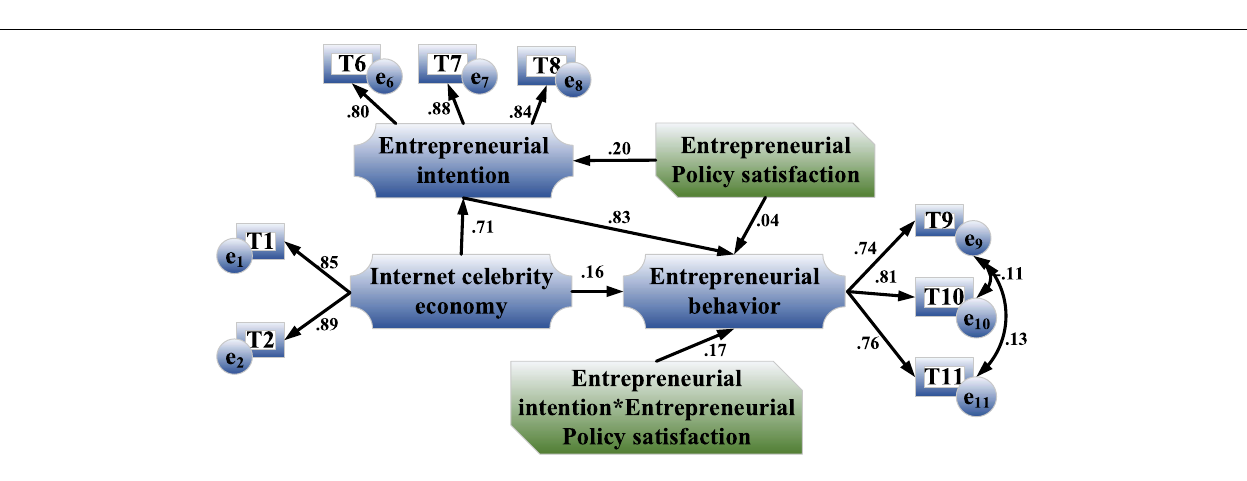
Frontiers in Psychology |